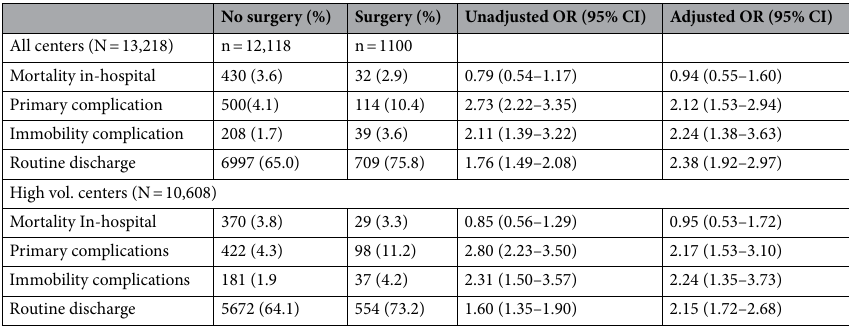
Table 2. Association of surgery with outcomes in geriatric C2 fractures. OR Odds ratio, CI Confidence